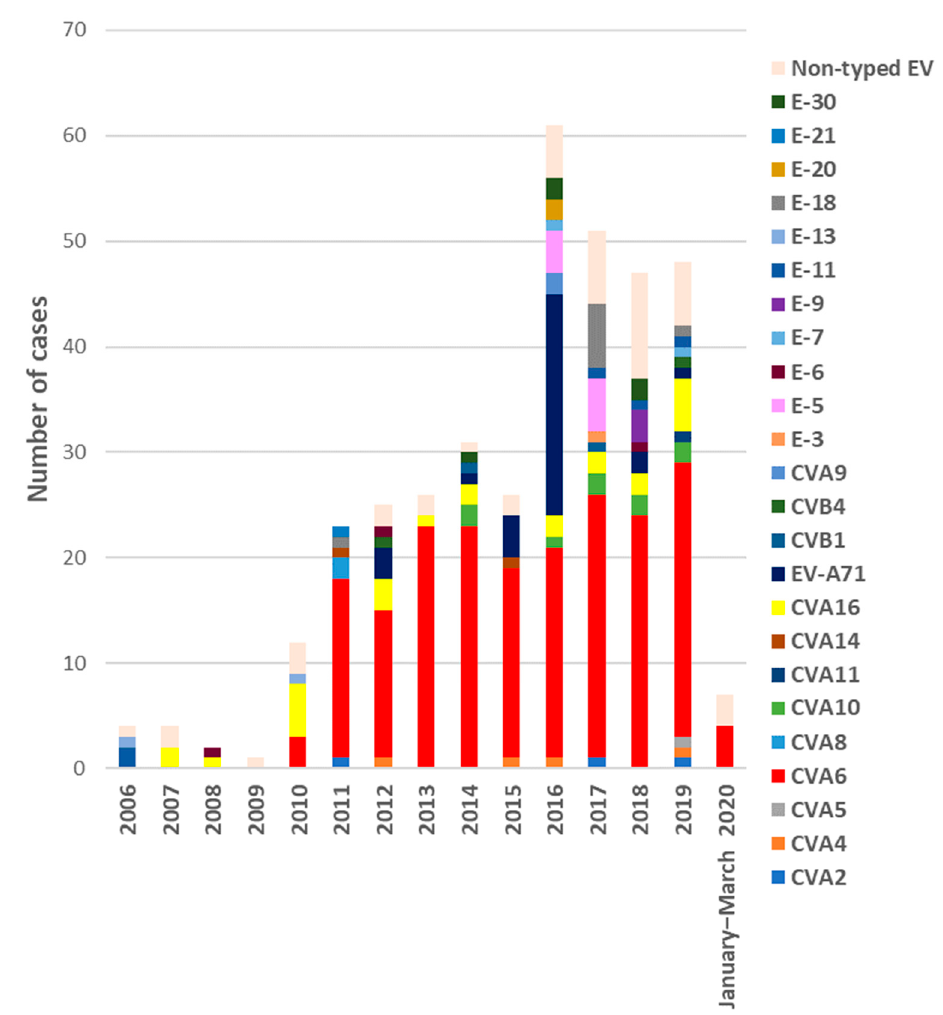
Figure 1. Number of EV-positive samples received from HFMD/exanthemas cases each year during the period of study (January 2006–March 2020) and annual distribution of the different EV types identified.